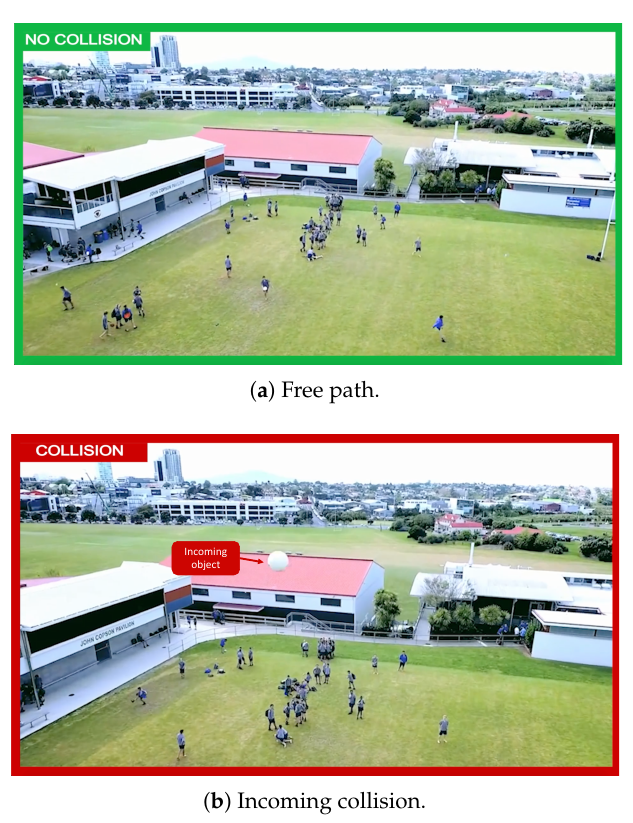
Figure 1. Novel Dynamic Collision Avoidance Detection. The images represent two frames from the same video, where a boy kicks a ball into a